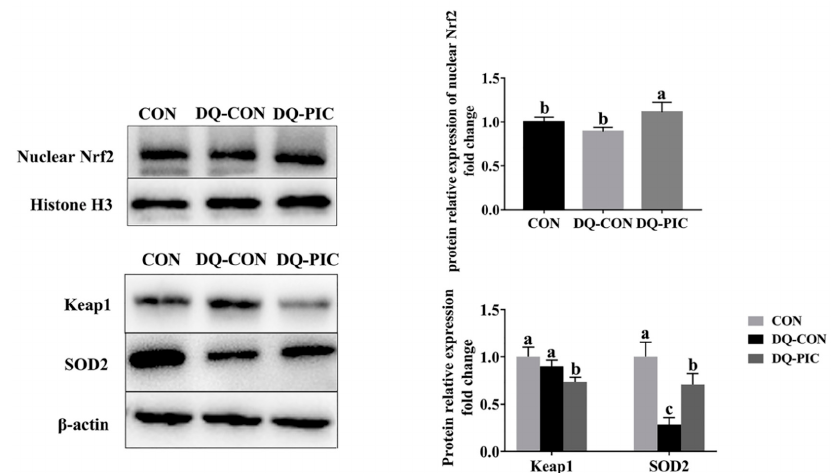
Figure 4. Effects of piceatannol supplementation on the expression levels of protein related to antioxidant in the liver of diquat-induced piglets. The column and its bar represented the means value and SE ( n = 6), respectively. Nrf2, nuclear-factor-erythroid-2-related factor 2; Keap1, kelch like ECH associated protein 1; SOD2, superoxide dismutase 2; CON, piglets were orally administrated vehicle solution (0.5% sodium carboxymethyl cellulose) and challenged with sterile saline; DQ-CON, piglets were orally administrated vehicle solution and challenged with diquat (10 mg / kg body weight); DQ-PIC, piglets were orally administrated piceatannol (80 mg / kg / day) and challenged with diquat (10 mg / kg body weight). a, b, c Di ff erent letters on the shoulder mark indicate significant di ff erences ( p < 0.05).